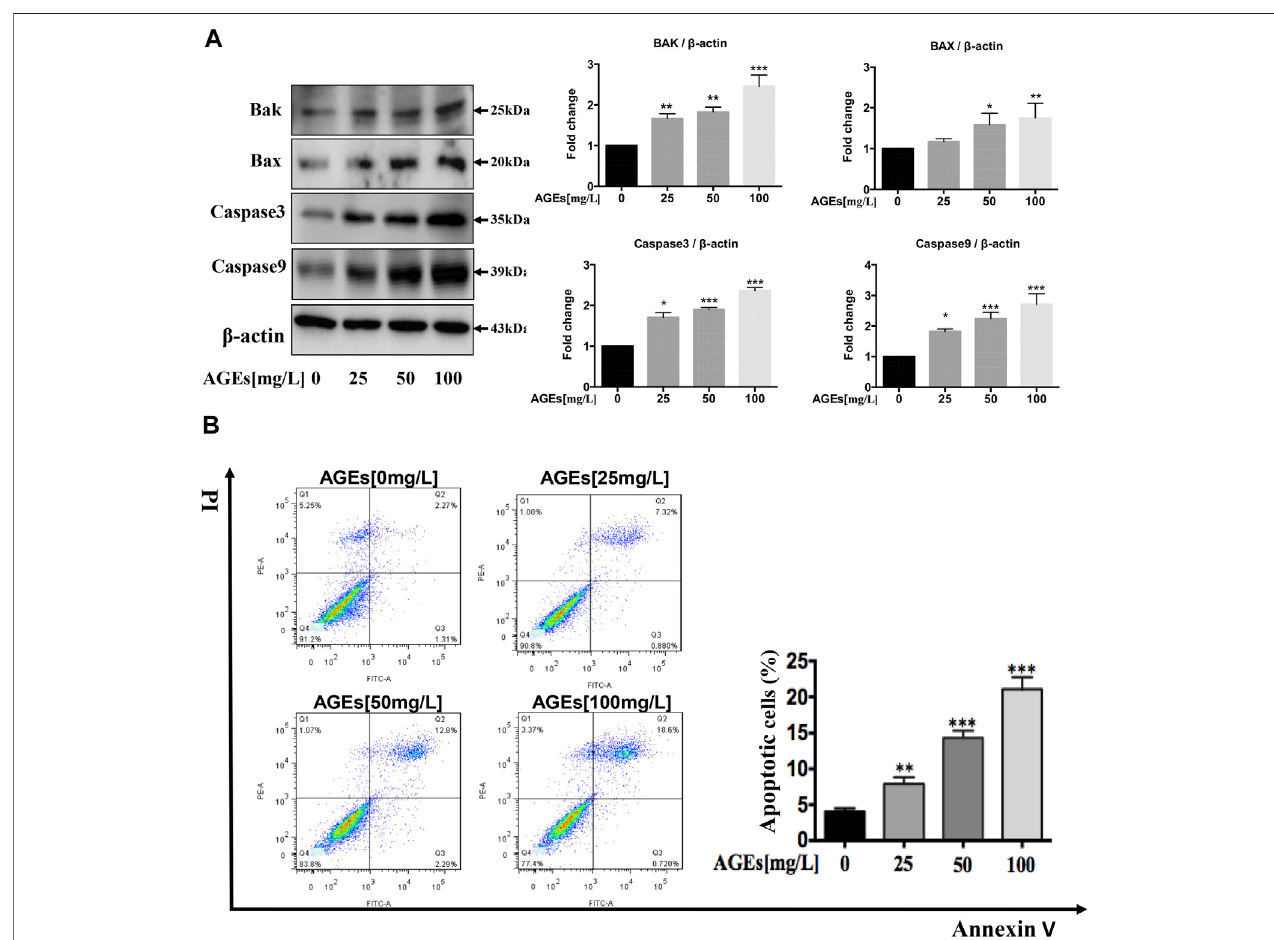
FIGURE3| AGEs induce apoptosisinHASMCs.Dose-dependentstudyofAGEs-inducedapoptosis inHASMCs atAGEs concentrationsfrom0to100 mg/L. (A) Westernblotanalysisofapoptosis-relatedproteins (Bak,Bax,caspase-3, andcaspase-9) inAGEs-treatedHASMCs. (B) FlowcytometryanalysisofapoptosisinAGEs- treated HASMCs. Data are presented with mean percentages of Q2 and Q3 quadrant. Each bar represents the mean ± SD ( n (cid:2) 3/group); *p < 0.05, ** p < 0.01, *** p < 0.001.